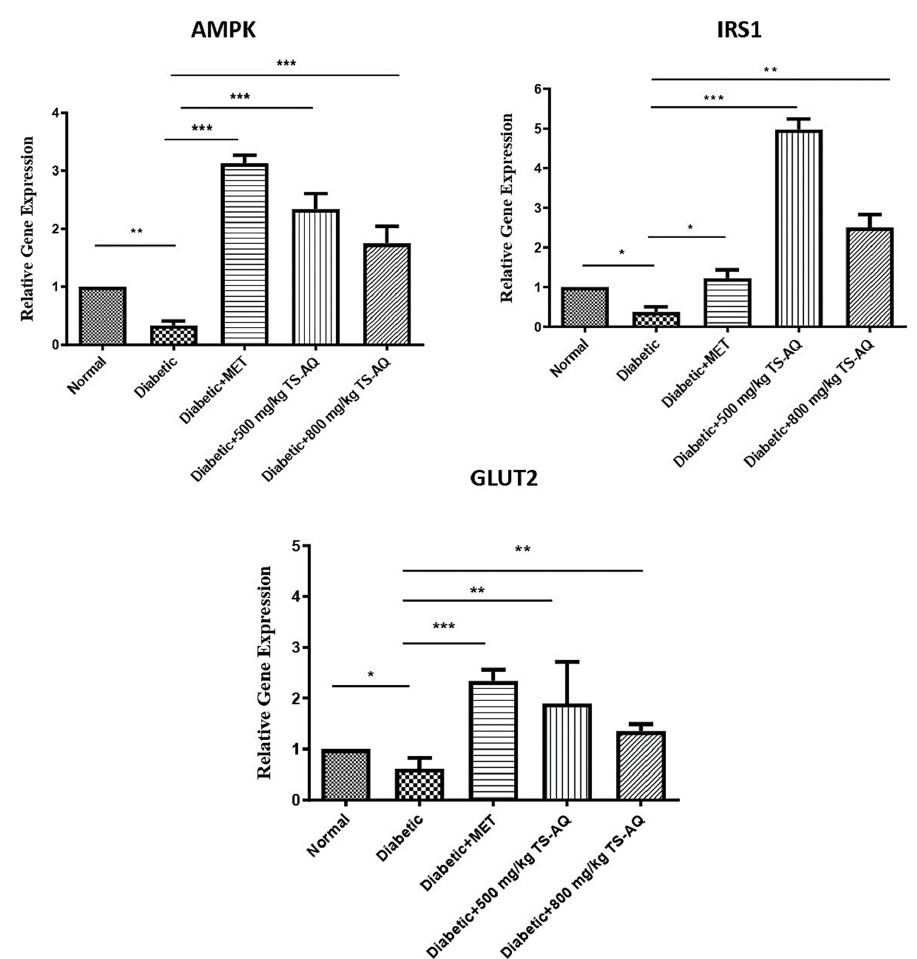
Figure 7. Expression analysis of AMPK , IRS1 , and GLUT2 genes. The expression of AMPK , IRS1 , and GLUT2 genes was upregulated after the administration of aqueous extract. The metformin-treated groups showed similar effect in AMPK and GLUT2 gene expression but little improvement in IRS1 signaling when compared to untreated control. Diabetic or untreated control showed downregulation of genes when compared to normal mice group. Data were obtained from three independent observations and presented as mean ± SD. * = p < 0.05. ** = p < 0.01. *** = p < 0.001.